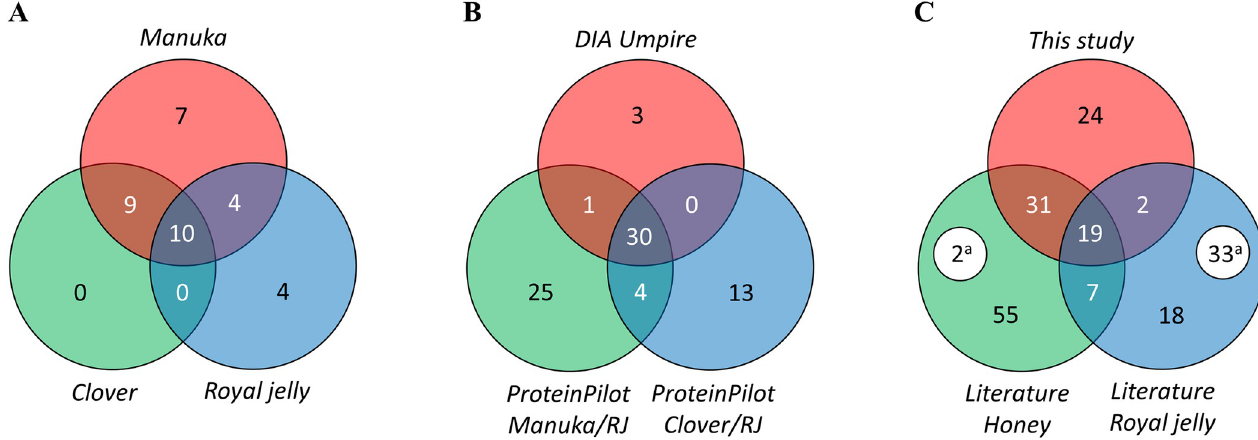
Fig 1. Protein identifications visualised by Venn diagram. (A) Proteins identified in DIA-Umpire by sample group. (B) Proteins identified in DIA-Umpire and the ProteinPilot comparisons of m ā nuka with royal jelly and clover with royal jelly. (C) Proteins identified in this study and proteins identified in the literature in honey and royal jelly. a proteins removed from the NCBI RefSeq